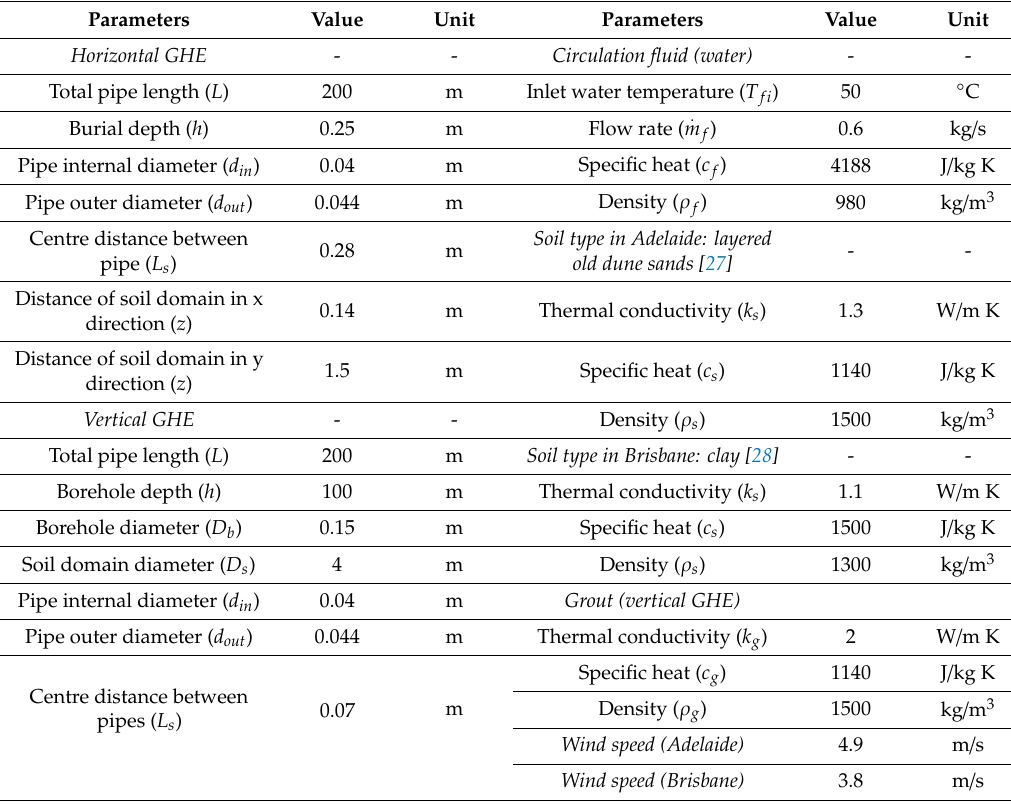
Table 1. The parameters of the reference